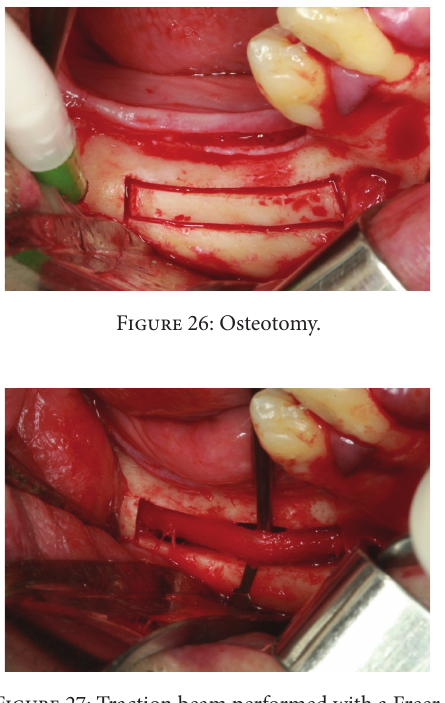
Figure 27: Traction beam performed with a Freer.